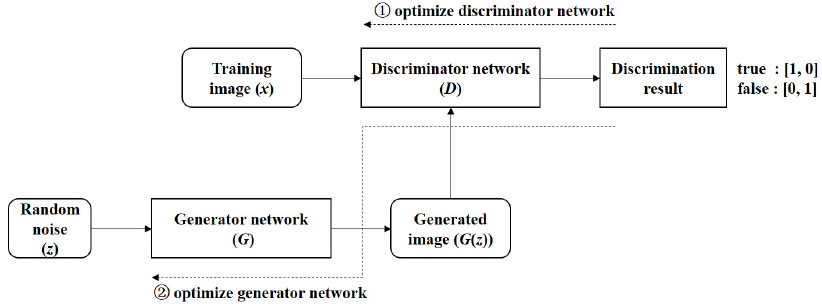
Figure 4. Schematic diagram of implementation of generative adversarial networks.